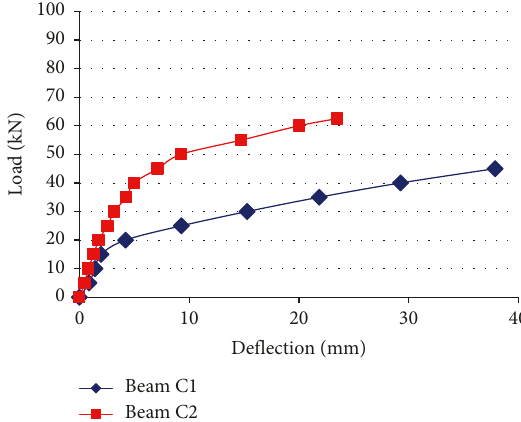
Figure 6: Effect of carbon fiber on load deflection response for beams having clear span � 1900mm.